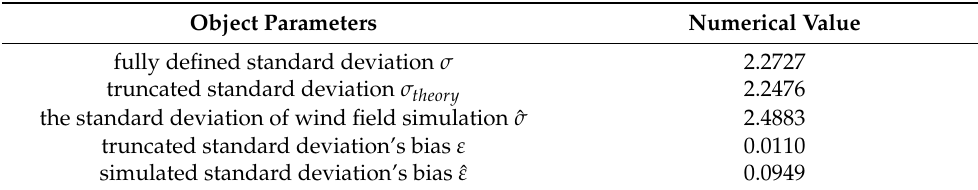
Table 6. Parameters’ contrast between being corrected and uncorrected. Table 5. The compensation coefficient of relevant parameters.